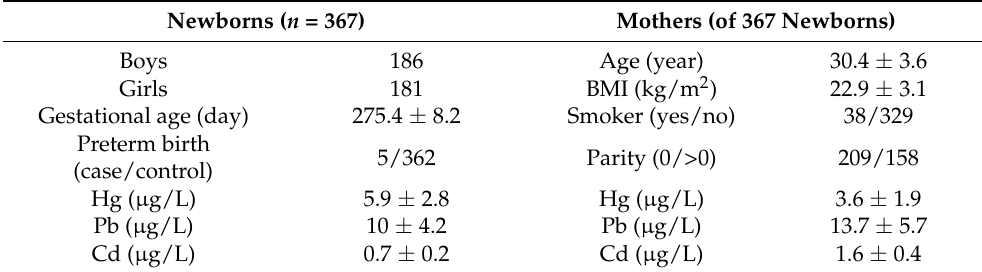
Table 1. Demographic description of subjects after imputation and filtration (mean ± standard deviation).